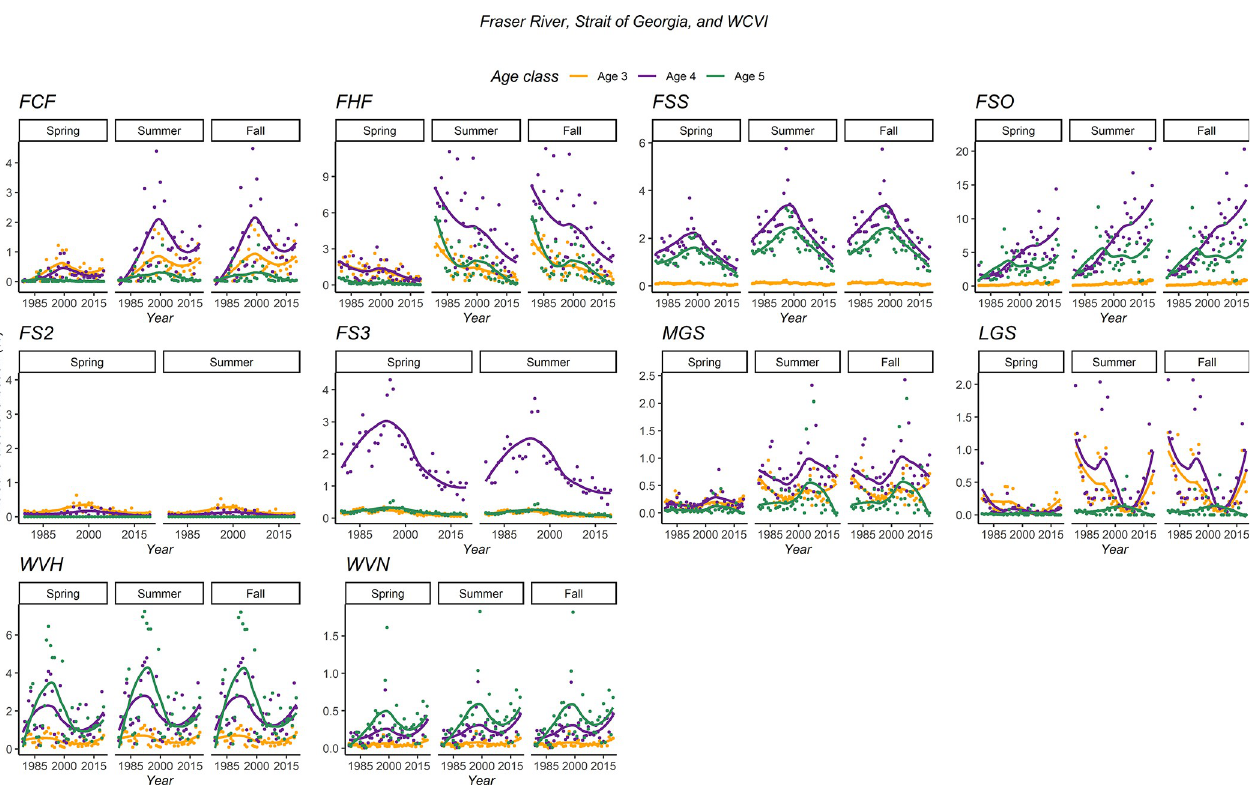
Fig 8. Estimated relative proportion of age-3, age-4, and age-5 Chinook salmon in the SRKW diet from 1979 to 2020. The stock IDs refer to the PSC model, and all stocks are originating from the Fraser River, Strait of Georgia, and West Coast of Vancouver Island.